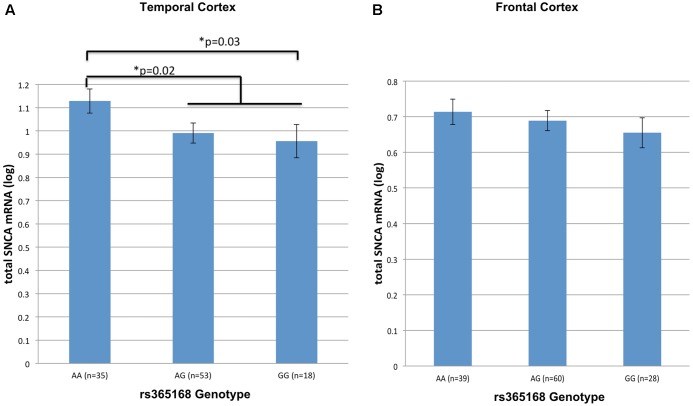
The effect of rs356168 on SNCA mRNA expression levels in human brain tissues. The study cohort consisted of unaffected control brain tissues from Caucasian donors. The subjects were genotyped for rs356168. Fold levels of human SNCA-mRNA were assayed by real-time RT-PCR using TaqMan technology, and calculated relative to the geometric mean of SYP- and ENO2- mRNAs reference control, using the 2-ΔΔCT method (i.e., results presented are relative to a specific brain RNA sample). The values presented here are means levels ± SE adjusted for age, sex, tissue source and PMI. GLM analysis was used to test the association of rs356168 with SNCA mRNA expression levels in the (A) temporal cortex (TC), and (B) frontal cortex (FC). Significant differences are denoted by ∗.